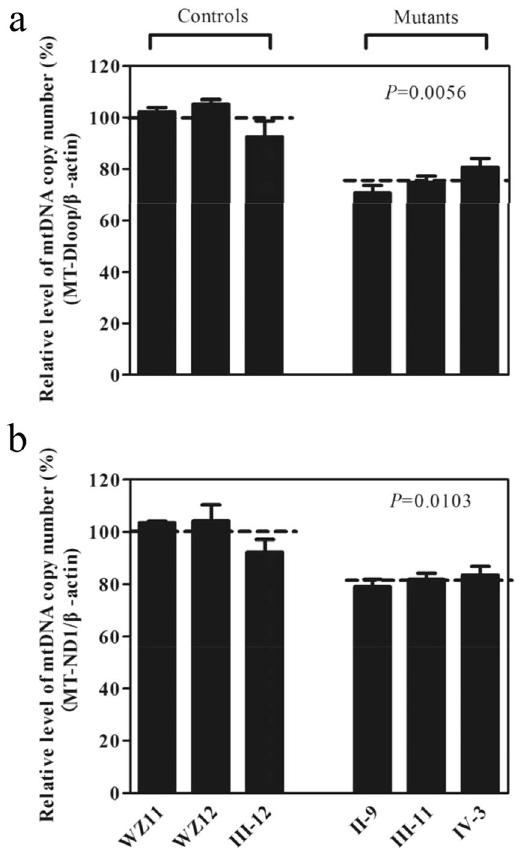
Figure 2. Measurements of mtDNA copy numbers in lymphoblastoid cell lines. The mtDNA copy numbers were determined by comparing the ratio of mtDNA to nDNA ( β -actin) by real-time quantitative PCR. ( a ) The ratio of MT-D-loop region to β -actin. ( b ) The ratio of MT-ND1 to β -actin. The calculations were based on three independent determinations. The error bars indicate two standard errors of the mean (SEM). P indicates the significance, according to the Student t-test, of the differences between the mean of mutant and that of control cell